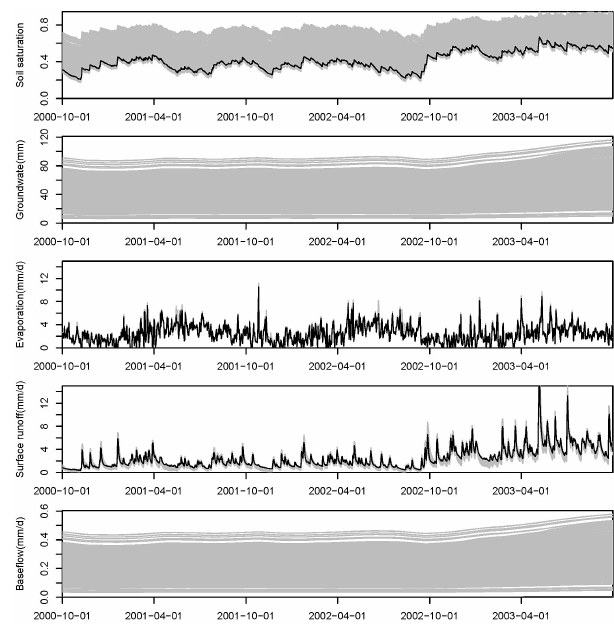
Figure 10. Time series of watershed average storages (soil water storage expressed as soil saturation, and groundwater depth), and fluxes (evaporation, surface runoff, and baseflow) with MOO (grey) and SOO (black line). For SOO, the groundwater storage and base- flow are close to 0 and hardly seen.